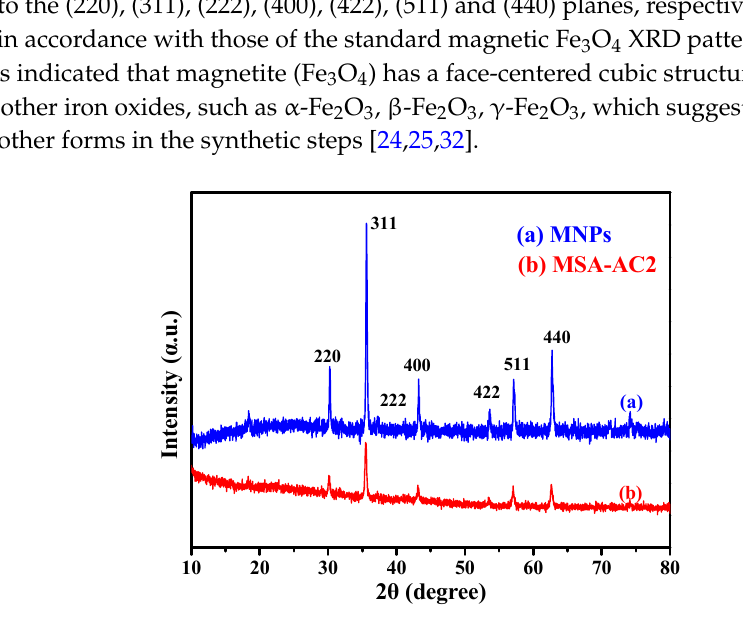
Figure 3. X-ray diffraction patterns of ( a ) MNPs (Fe 3 O 4 nanoparticles) and ( b ) MSA-AC2.